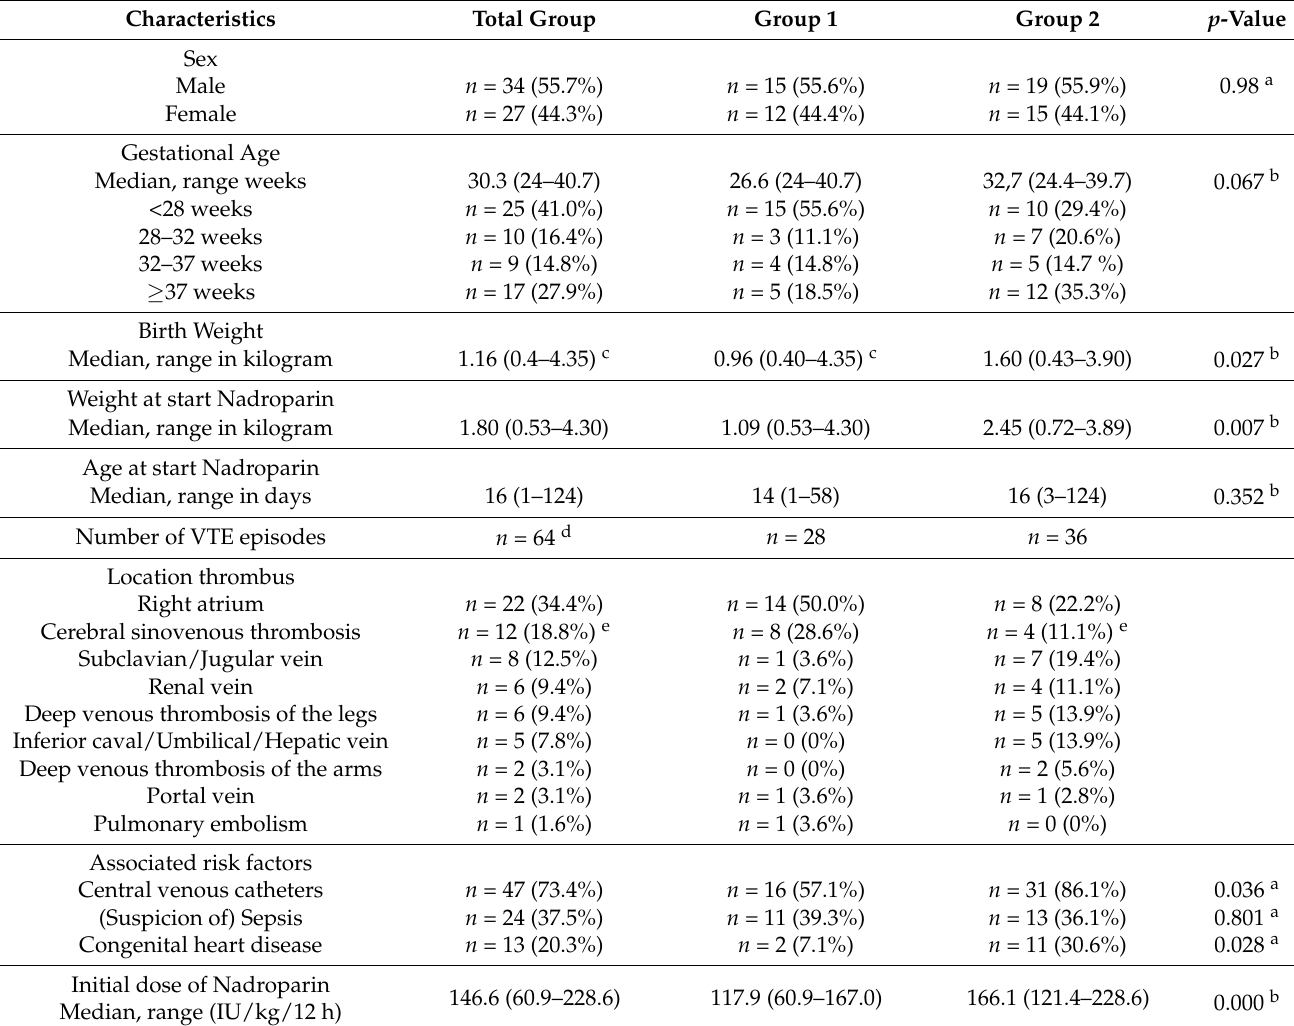
Table 1. Baseline characteristics of 64 VTE (venous thromboembolism) episodes in 61 preterm and term neonates treated with